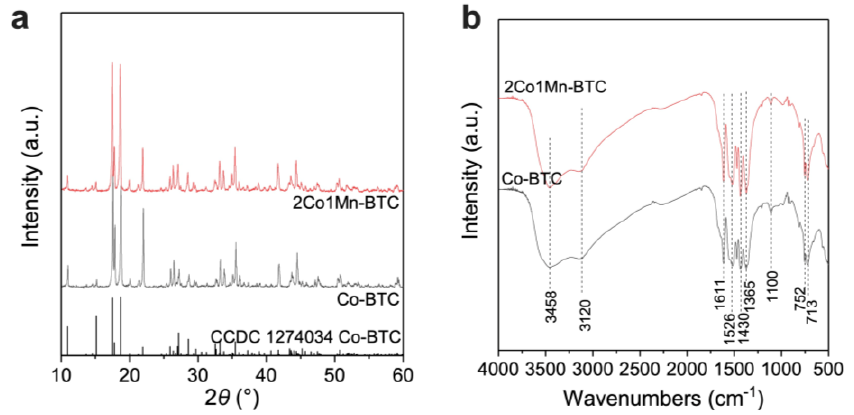
Figure 2. ( a ) XRD patterns and ( b ) IR spectrum of Co-BTC and 2Co1Mn-BTC precursors.